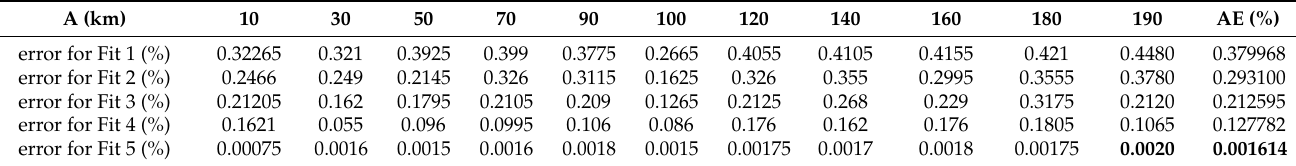
Table 14. LLL-G fault prediction error.